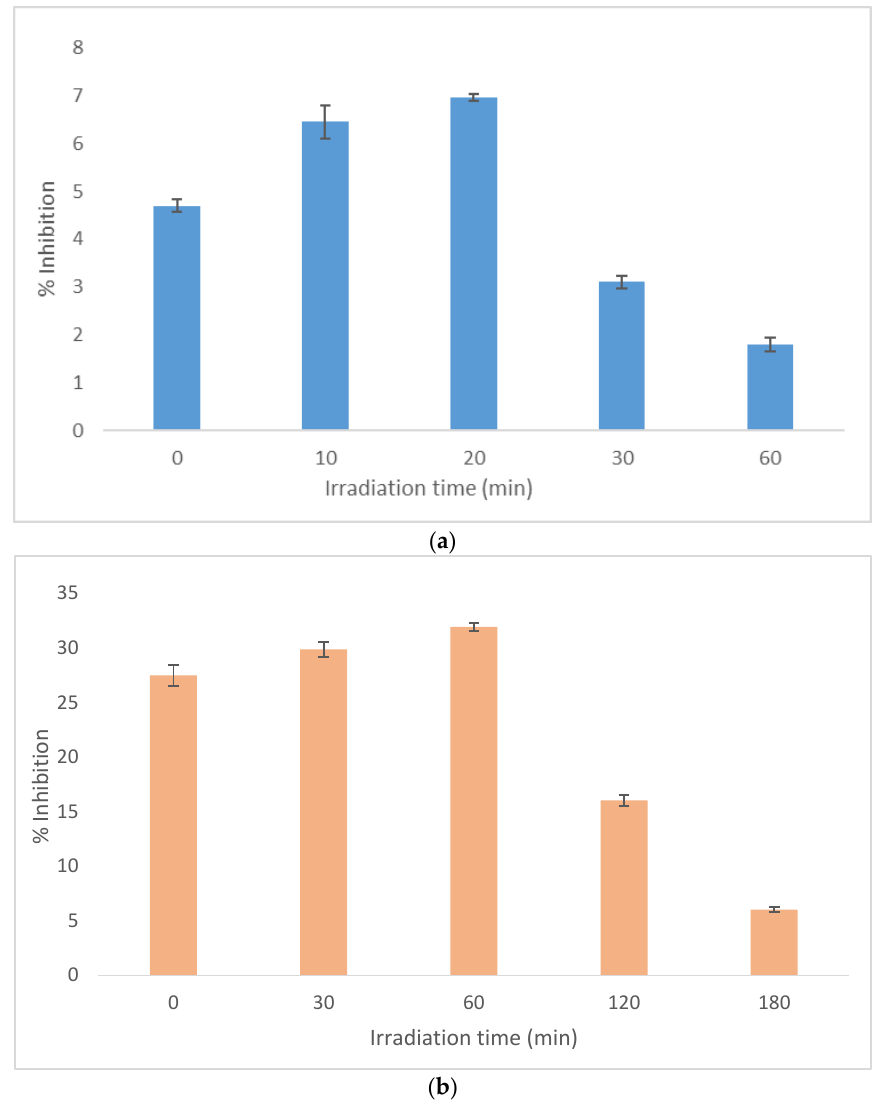
Figure 7. Evolution of toxicity during the photocatalytic process in: ( a ) UW; and ( b ) WW using Dunaliella tertiolecta ([amisulpride] 0 = 1 mg L −1 ; [g-C 3 N 4 ] = 300 mg L −1 ).